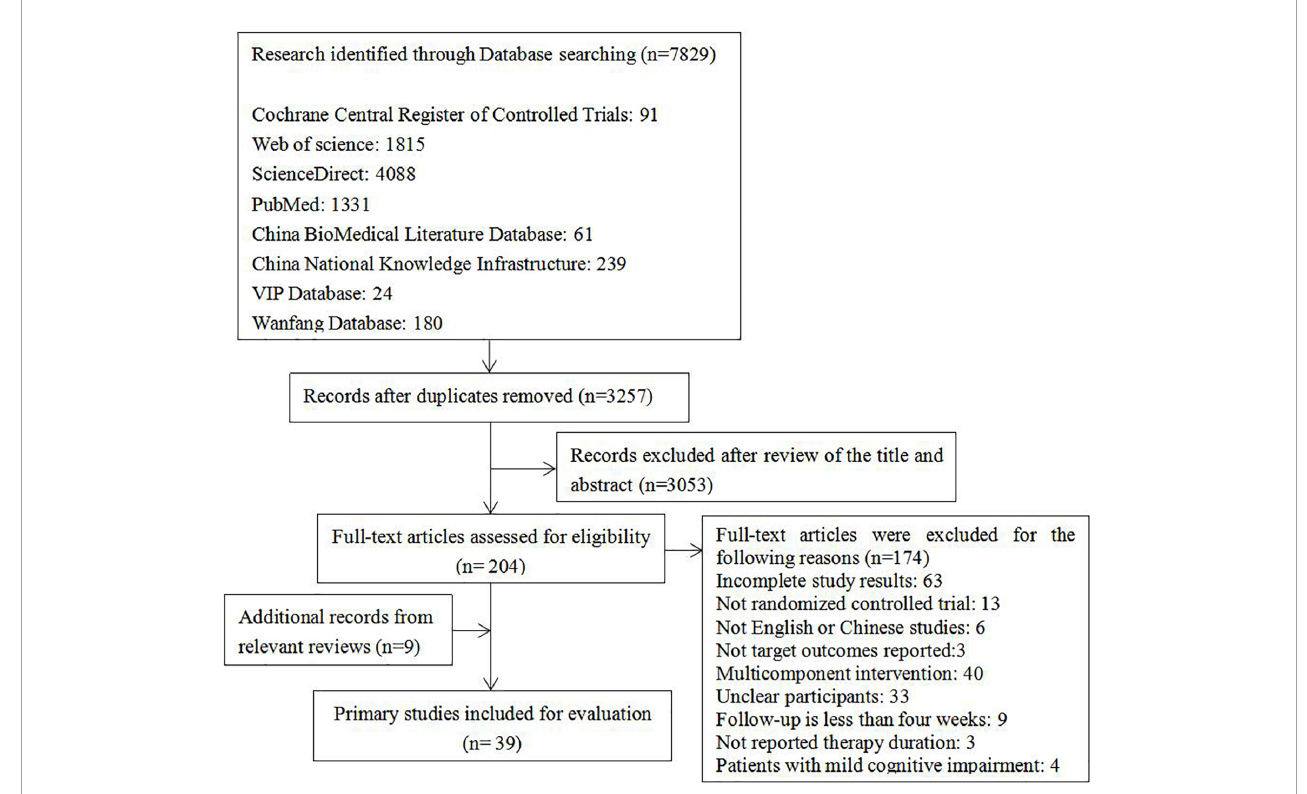
FIGURE1 Study flow